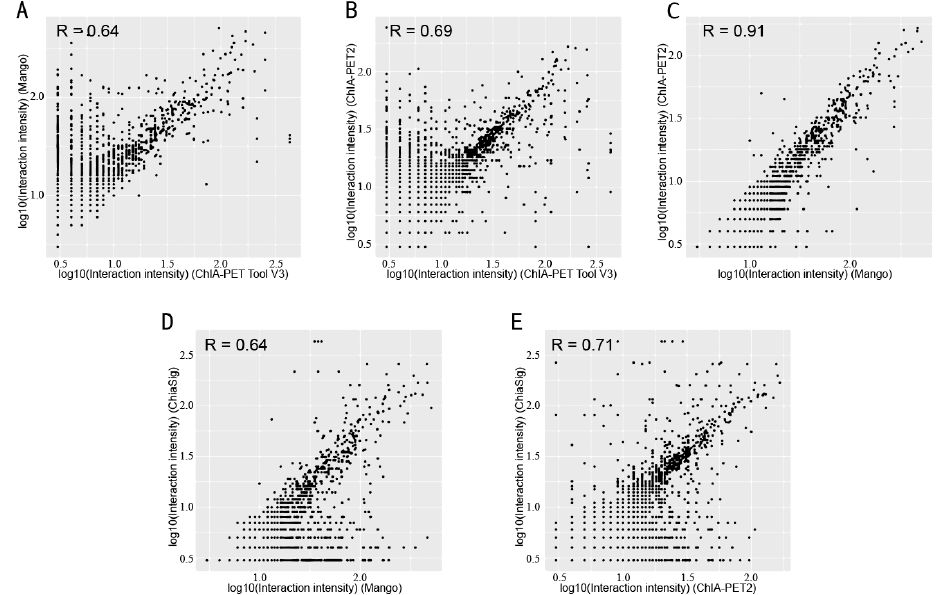
Figure 16. Scatter plots of interaction intensity between different tools from human K562 cells. ( A ) Interaction intensity between ChIA-PET Tool V3 and Mango. ( B ) Interaction intensity between ChIA-PET Tool V3 and ChIA-PET2. ( C ) Interaction intensity between Mango and ChIA-PET2. ( D ) Interaction intensity between Mango and ChiaSig. ( E ) Interaction intensity between ChIA-PET2 and ChiaSig.